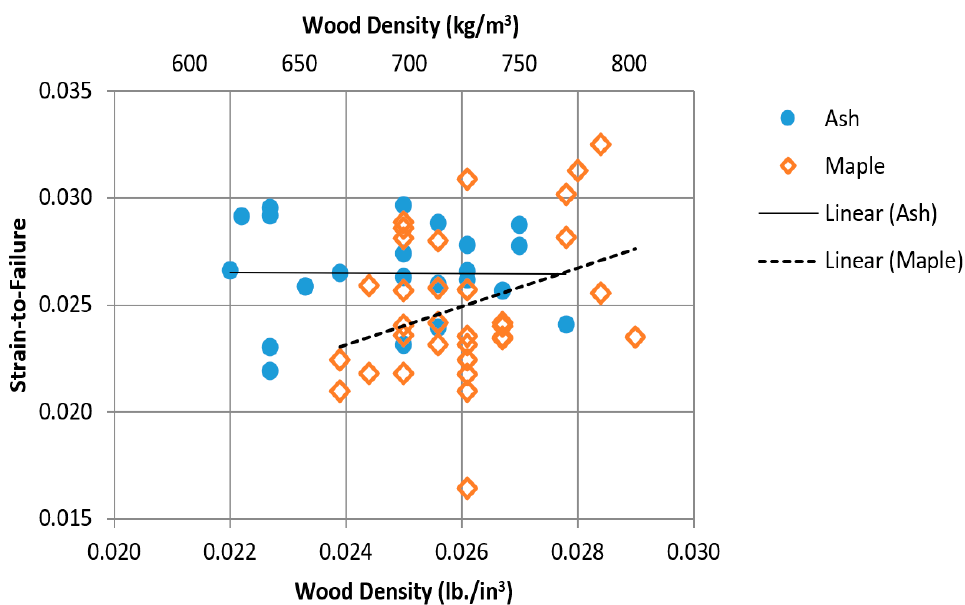
Figure 5. Strain-to-failure as a function of wood density for ash samples impacted edge-grain and maple samples impacted face-grain.